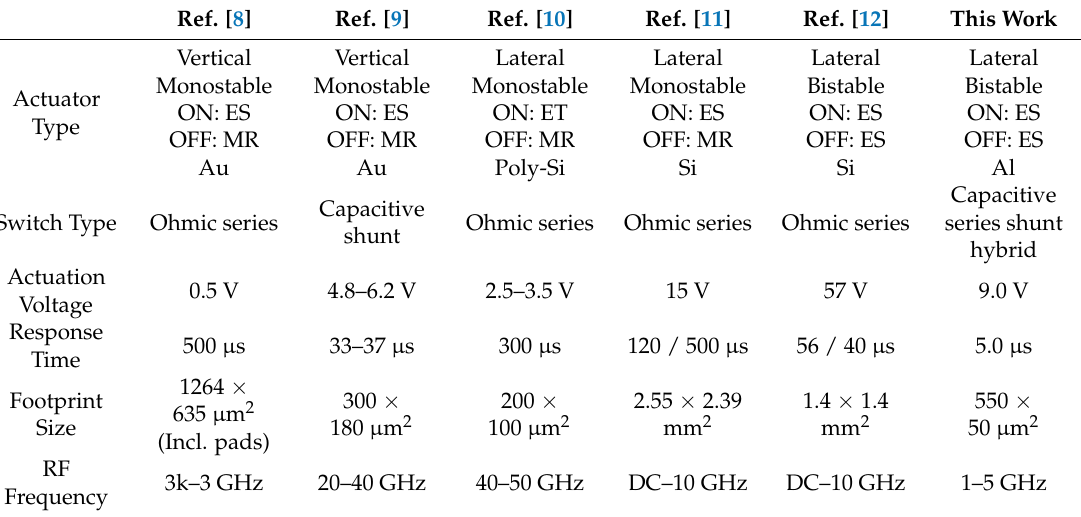
Table 3. Comparison of low voltage actuators in RF-MEMS